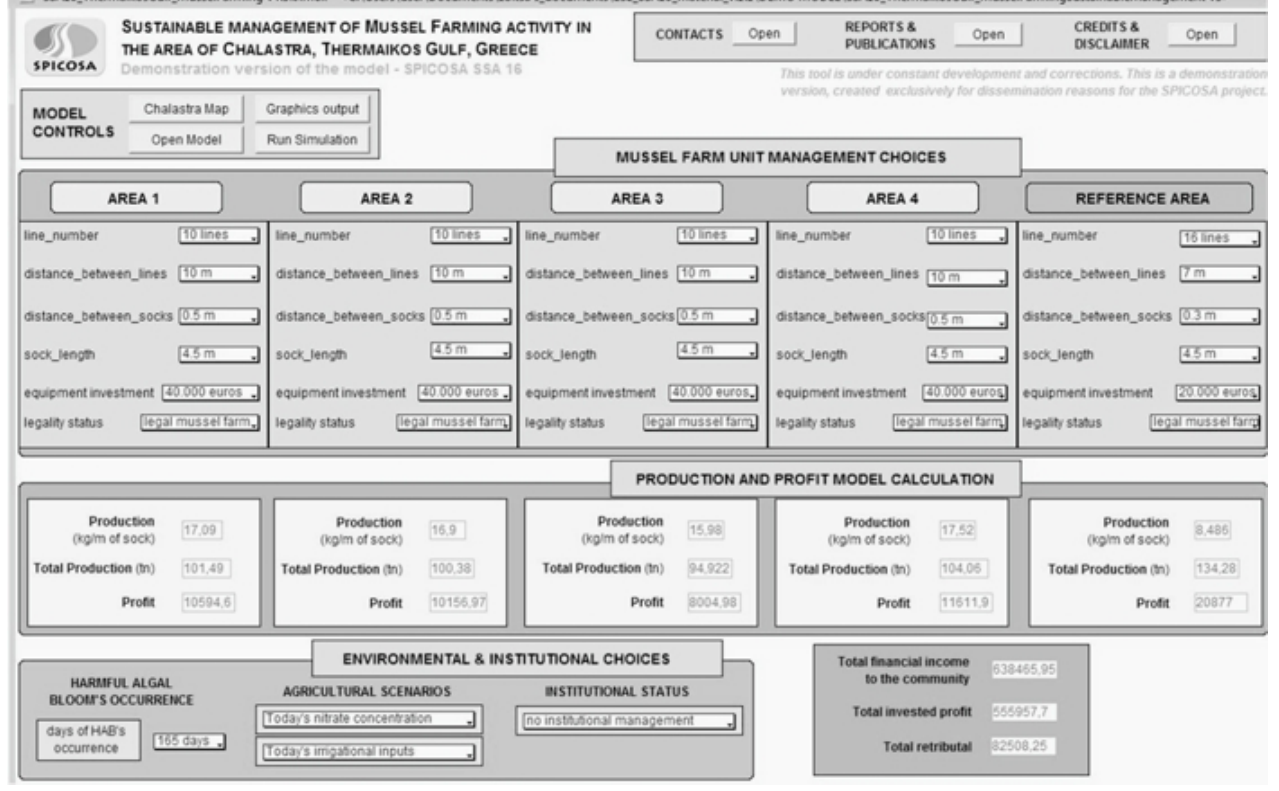
Fig. 3 . Layout of the current version of the management